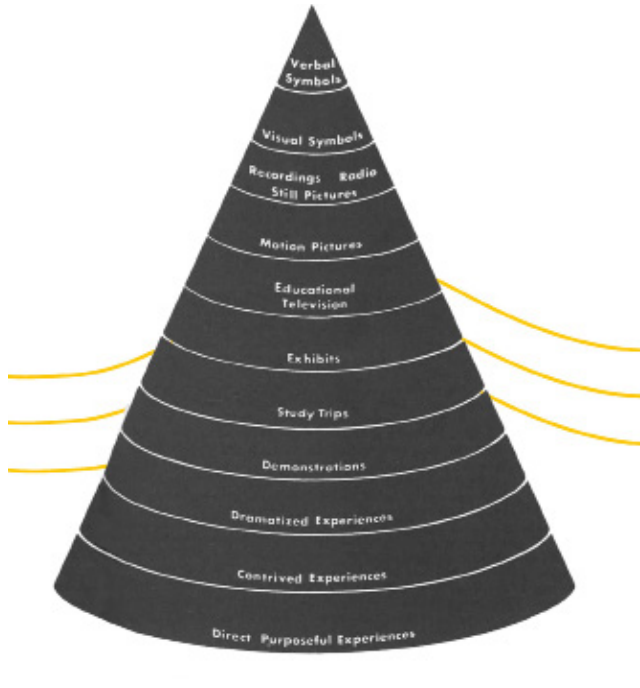
Fig. 1 Edgar D., The cone